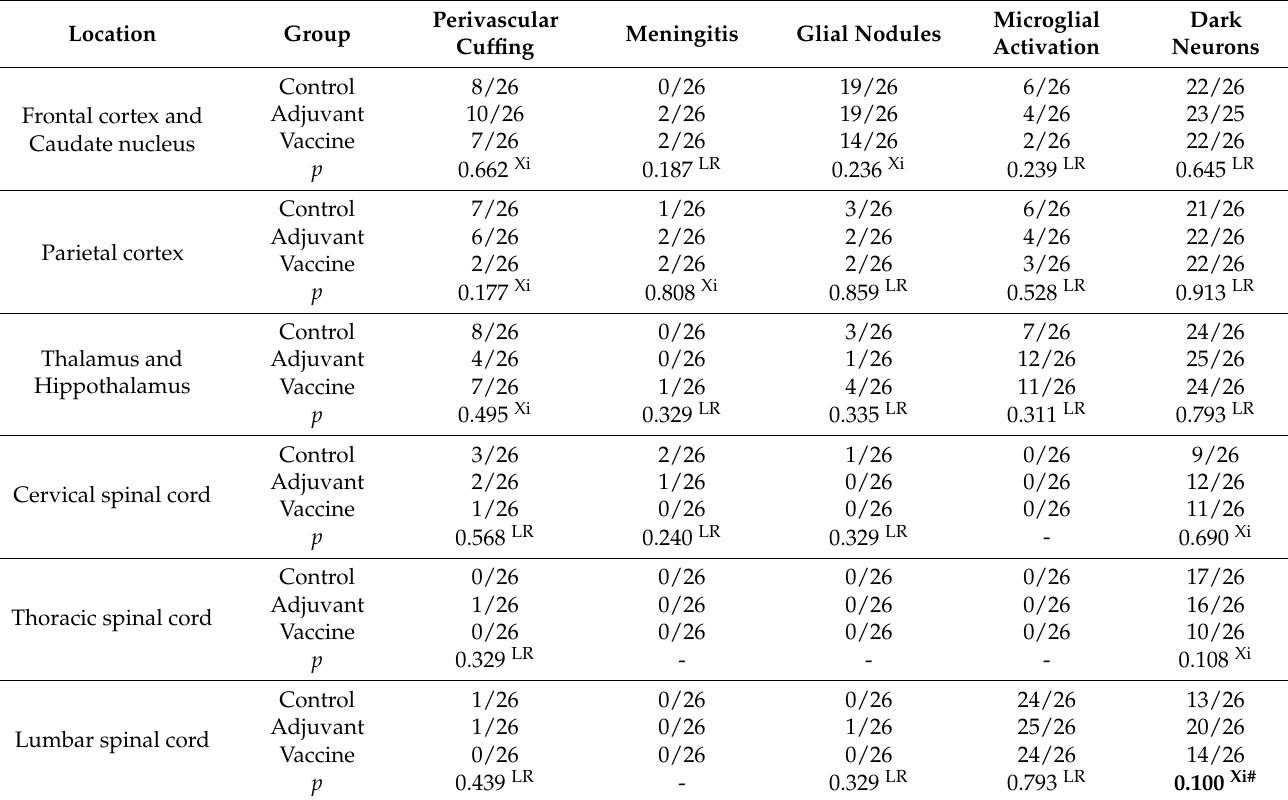
Table 3. Histopathological findings in the central nervous system in Control, Adjuvant-only (Adjuvant), and Vaccine groups ( n = 26 each) of all flocks grouped together. Data provided as animals with the referred histological lesion relative to the total number of animals analyzed. Methodology of histopathological evaluation is detailed in Tables A3–A11 (Appendix D).